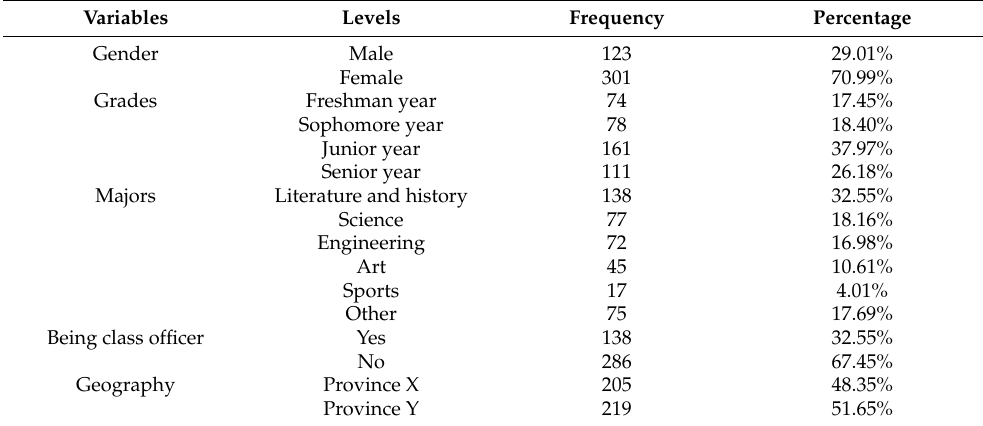
Table 1. Descriptive statistics of the participants (N = 424).